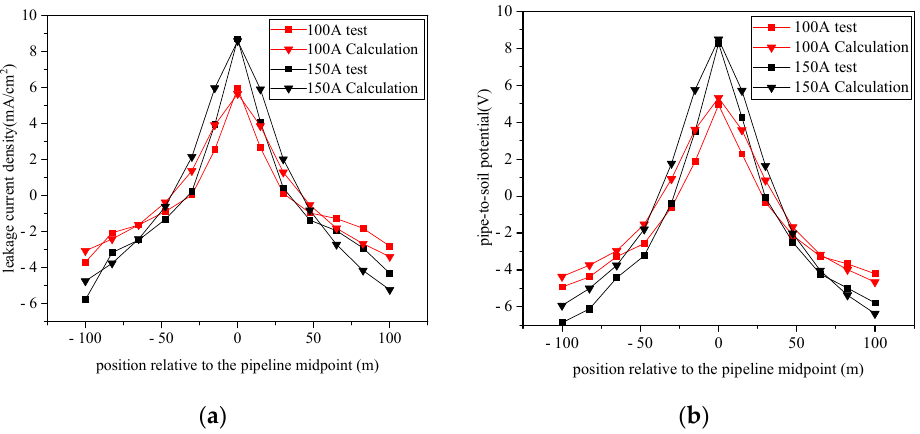
Figure 8. Results of test and calculation. ( a ) leakage current density along the pipeline; ( b ) pipe-to-soil potential along the pipeline.